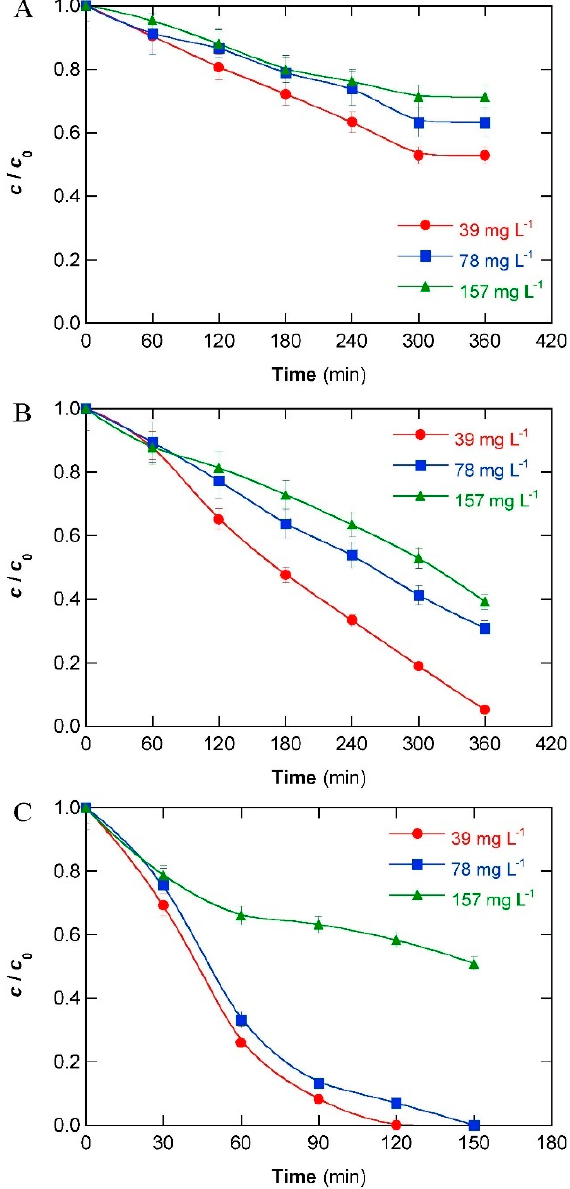
Figure 5. Normalized paracetamol concentration decay vs. electrolysis time for ( A ) EC, ( B ) PEC and ( C ) PEC + Cl - . Reproduced with permission [58].